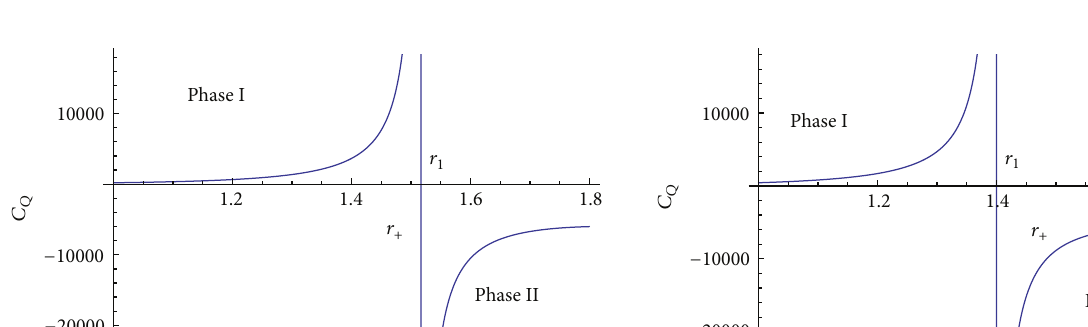
Figure 9: Plot of specific heat ( 𝐶 𝑄 ) against horizon radius ( 𝑟 + ), for 𝛼 󸀠 = 1.0 , 𝑄 = 0.05 , and 𝑏 = 0.05 at the critical point 𝑟 1 .